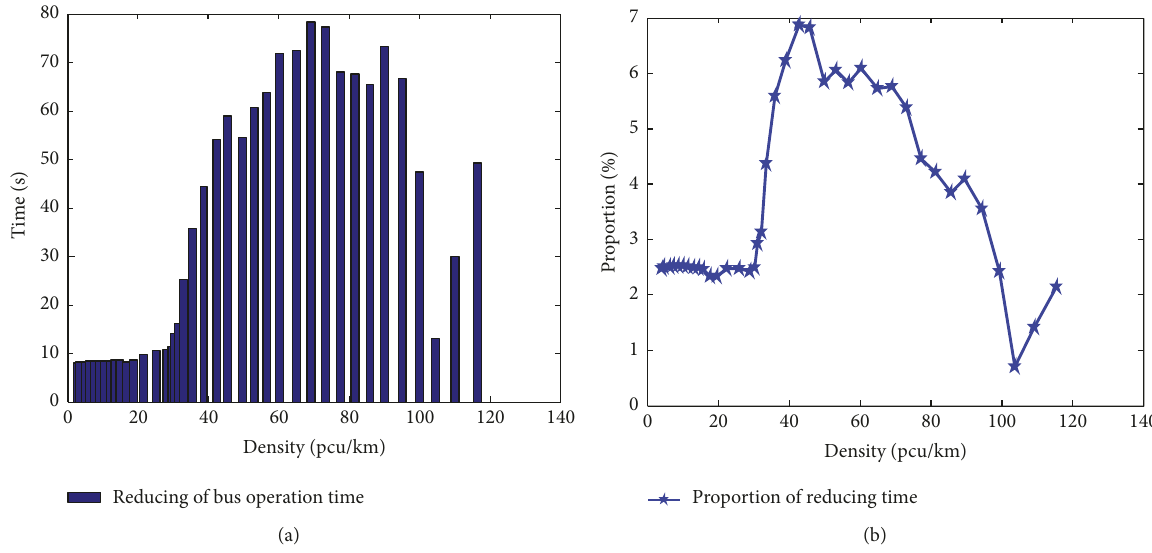
Figure 7: Average bus traveling time saving by BLIP in different traffic density scenarios. (a) Average bus traveling time saving by BLIP. (b) Proportion of average bus traveling time saving by BLIP.